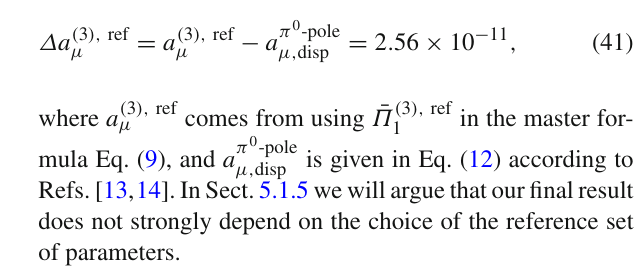
Fig. 2 for r = 0 together with the uncertainty band for the interpolants that we are going to discuss in the next